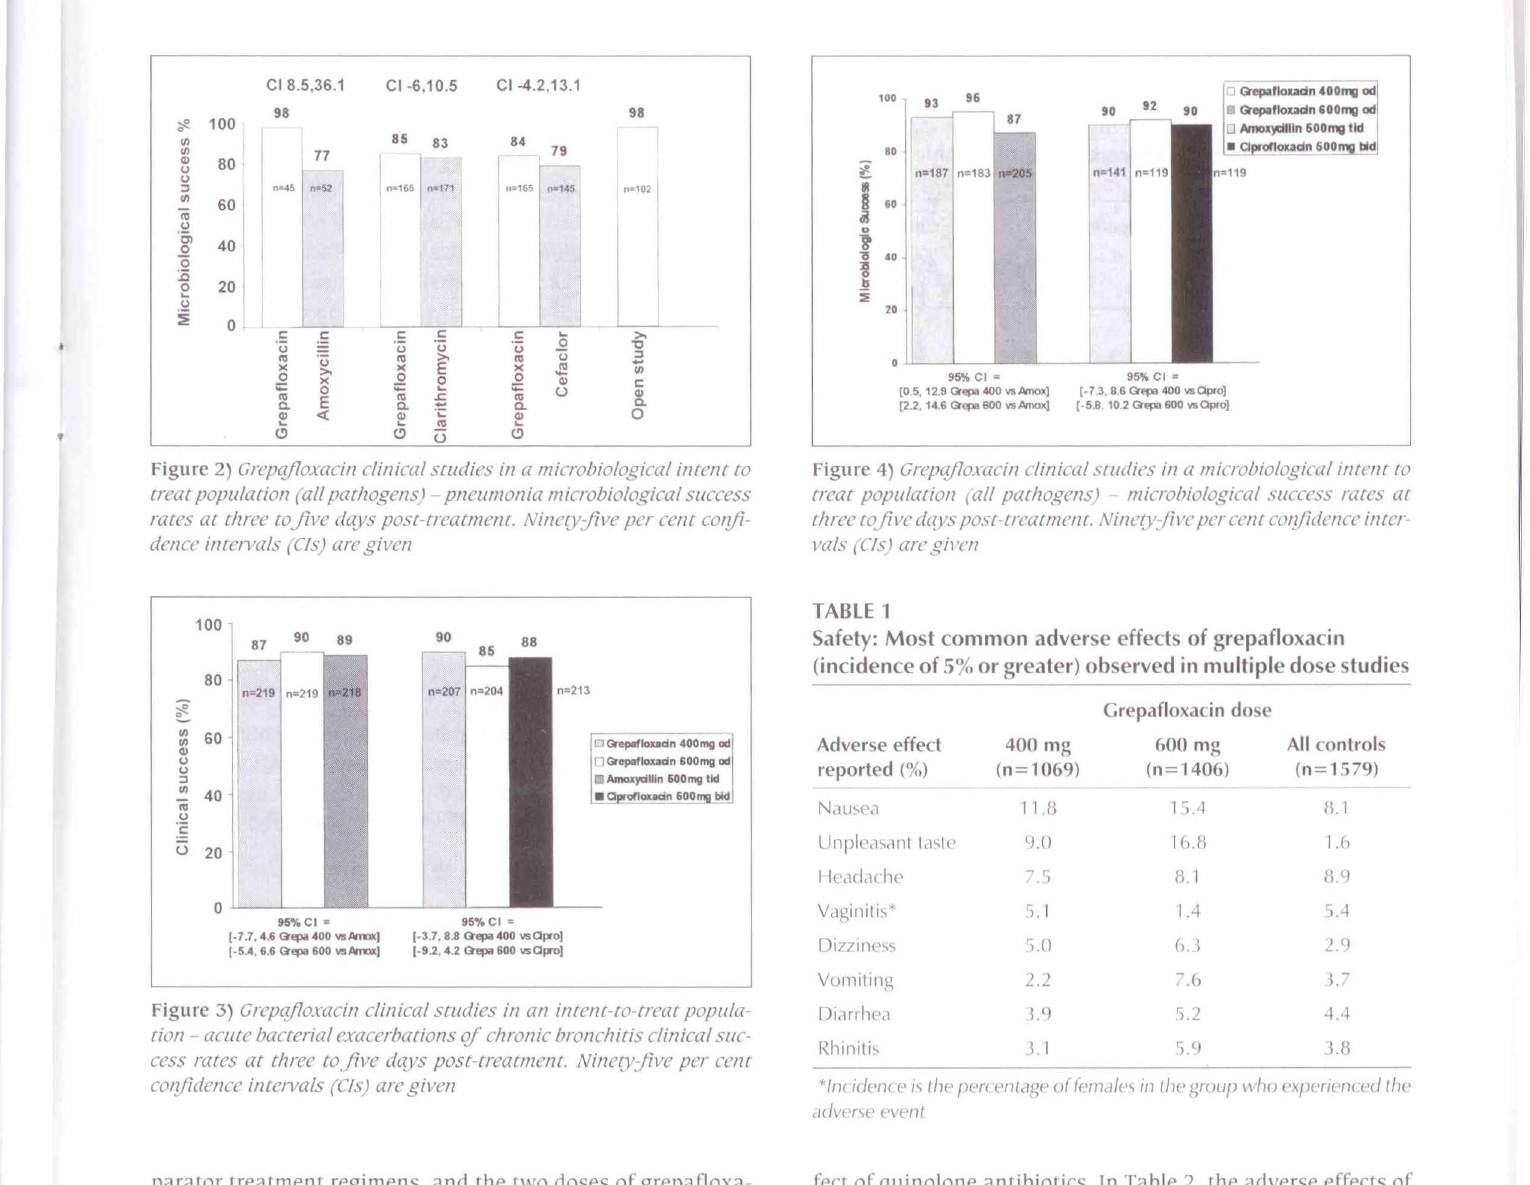
para tor treatment regimens, and the two doses of grepafloxa cin were equivalent (Figure 3).